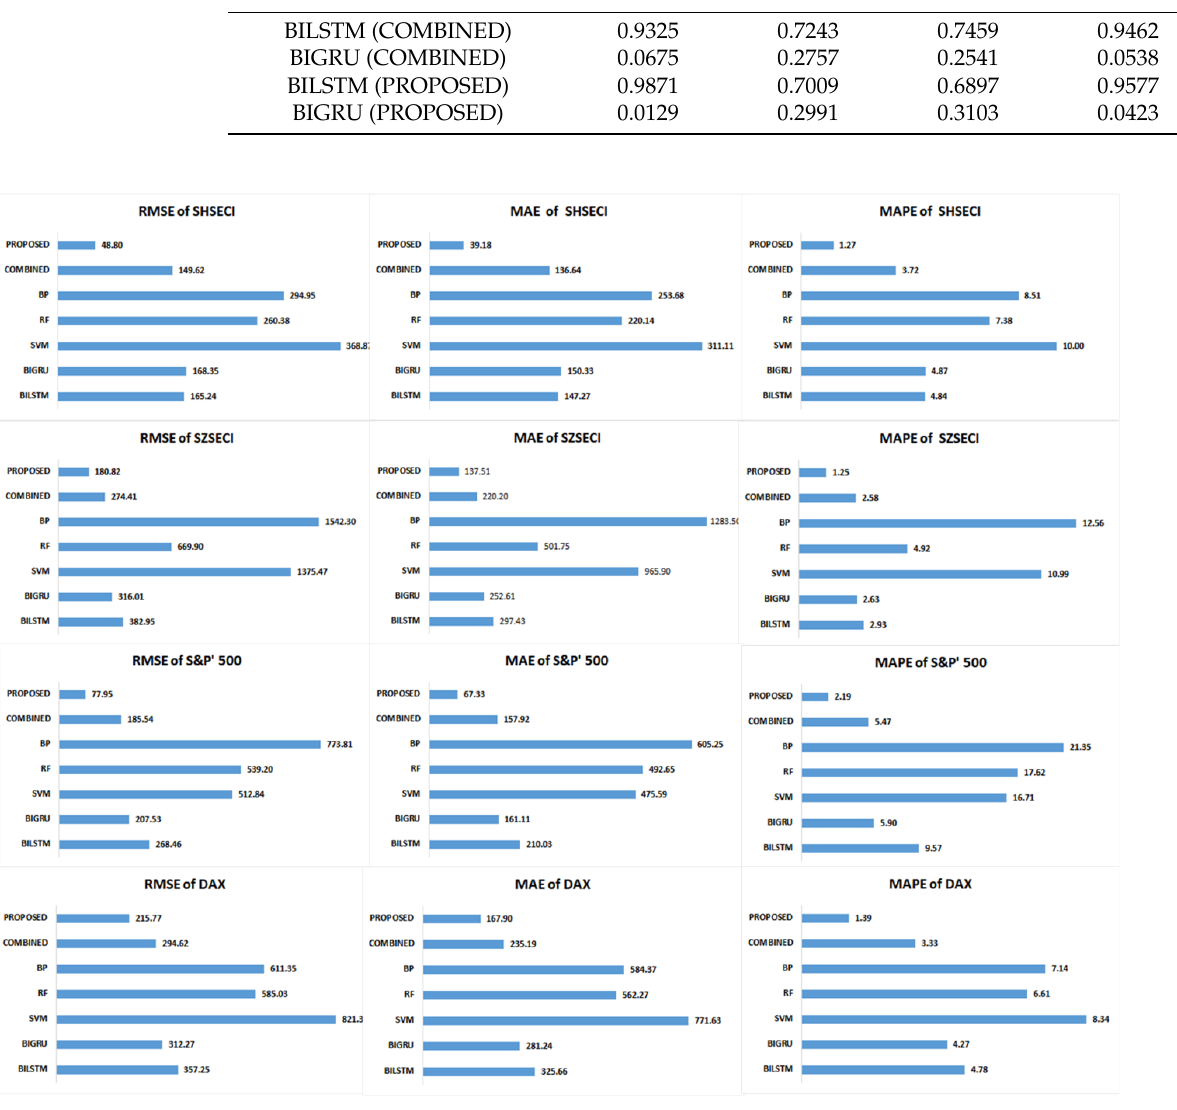
Figure 7. Prediction results of four stock indices with 7-day lag.